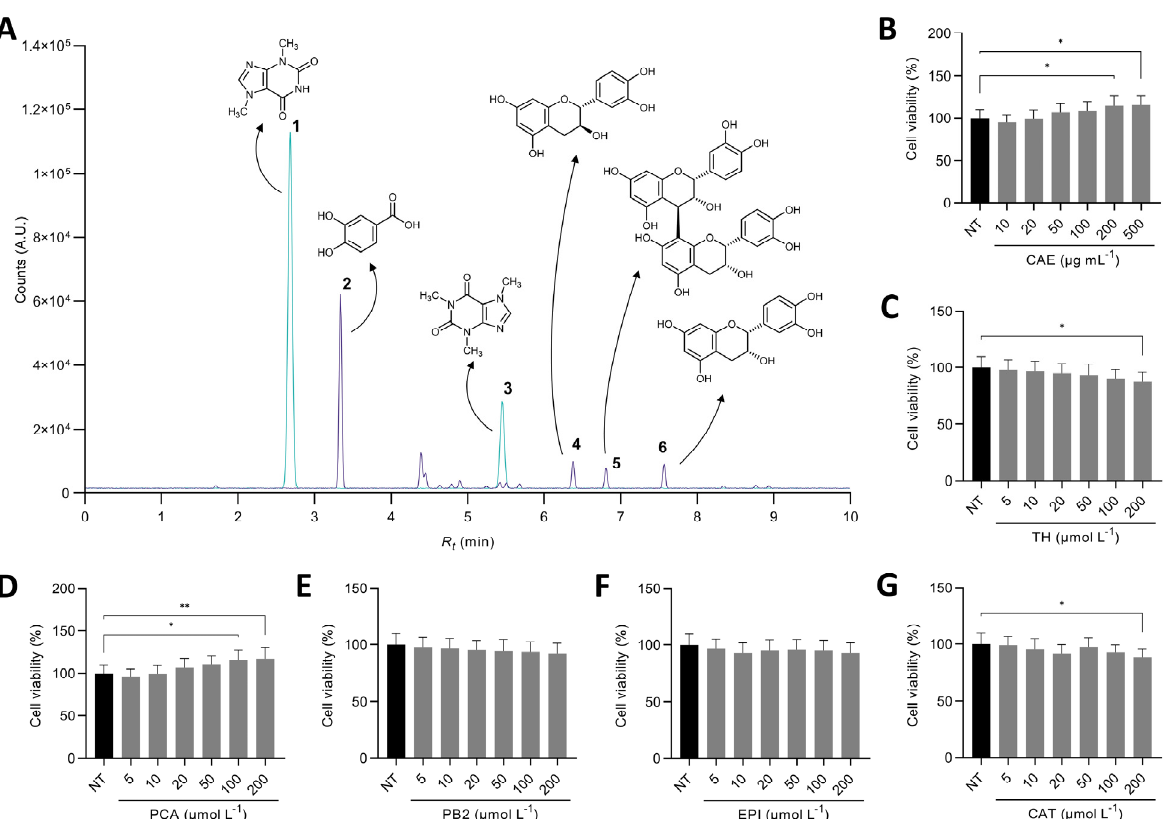
Figure 1. Superimposed UPLC–MS/MS chromatograms of the targeted analysis of phytochemicals from the cocoa shell aqueous extract (CAE) operating the MS detector in negative and positive modes ( A ). Primary compounds found in CAE were theobromine (1), protocatechuic acid (2), caffeine (3), catechin (4), procyanidin B2 (5), and epicatechin (6). Cell viability of HepG2 cells treated with CAE ( B ), theobromine (TH) ( C ), protocatechuic acid (PCA) ( D ), procyanidin B2 (PB2) ( E ), ( − )-epicatechin (EPI) ( F ), and (+)-catechin ( G ). The results are expressed as mean ± SD ( n = 3). Asterisks (* or **) denote significant differences ( p < 0.05 or p < 0.01, respectively) according to the t -test between the non-treated control (NT) and each of the concentrations of CAE or pure compounds.